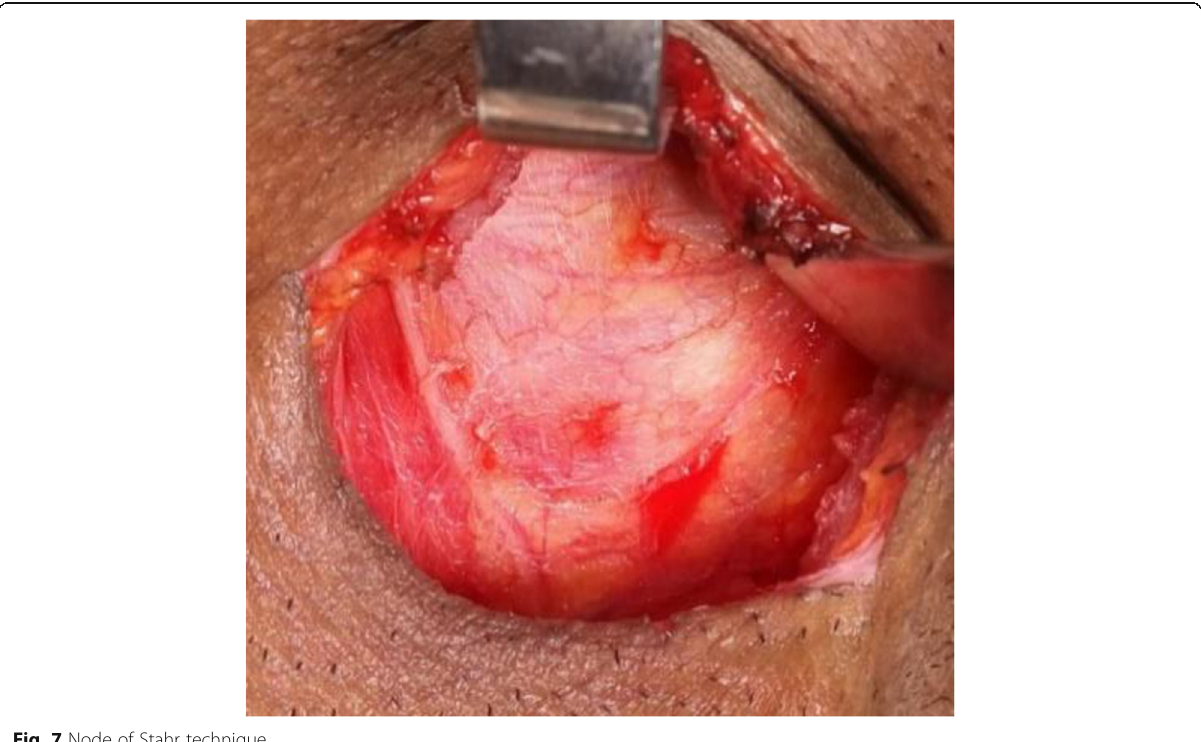
Fig. 7 Node of Stahr technique